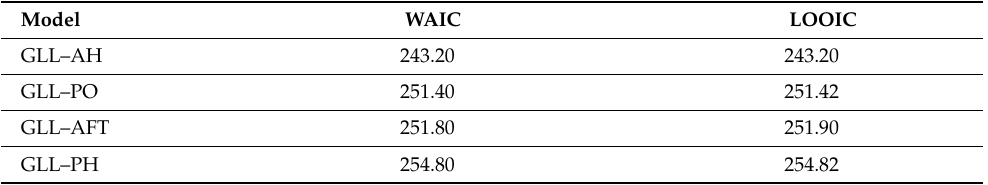
Table 7. Bayesian model comparison for the GLL–AH, GLL–PO, GLL–AFT, and GLL–PH models.